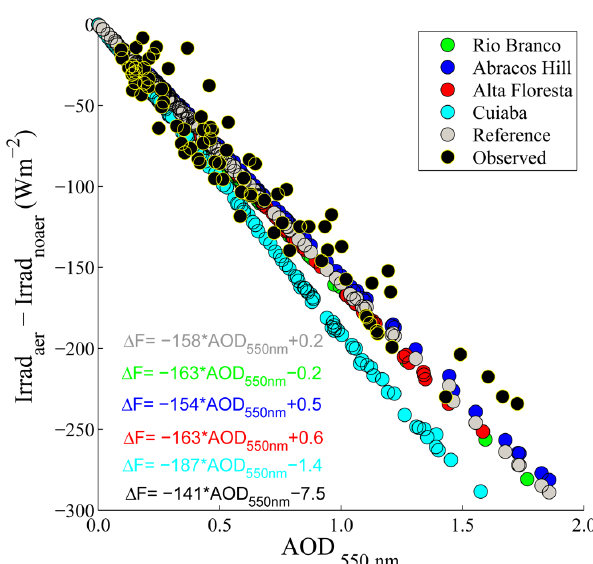
Fig. 9. Linear fitting of aerosol optical depth at 550nm versus the difference between downward surface solar irradiance considering (Irrad aer ) and neglecting (Irrad noaer ) the aerosol direct radiative ef- fect. For the observed case, denominated as the empirical approach, Irrad aer consists of pyranometer measurements and Irrad noaer was estimated using the SBDART code, prescribing water vapour and ozone from observations and turning off aerosol effects. The slopes represent estimates of aerosol radiative flux perturbation efficiency